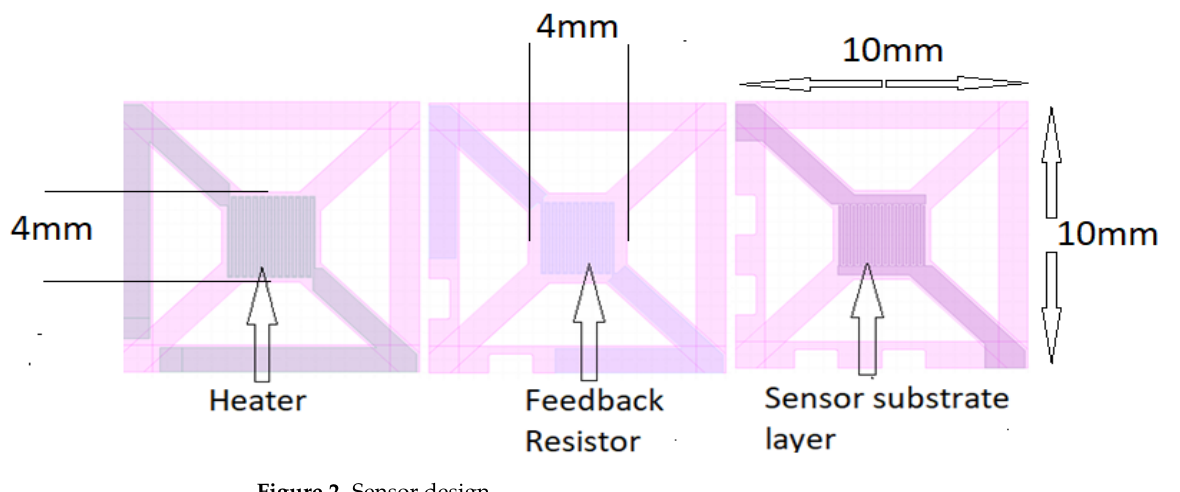
Figure 1. Fabrication process from LTCC ceramic transducer.